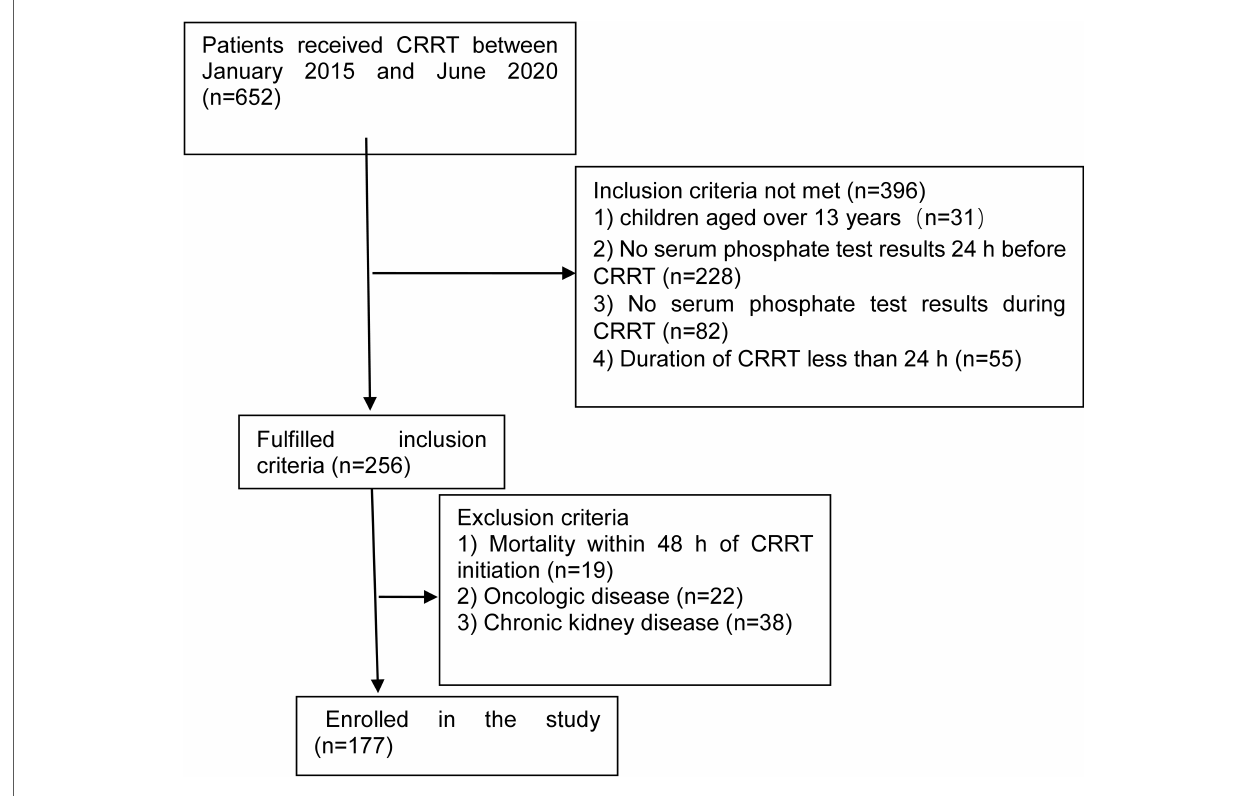
FIGURE 1 Flow chart showing participant categorization and interventions for this study. CRRT, continuous renal replacement